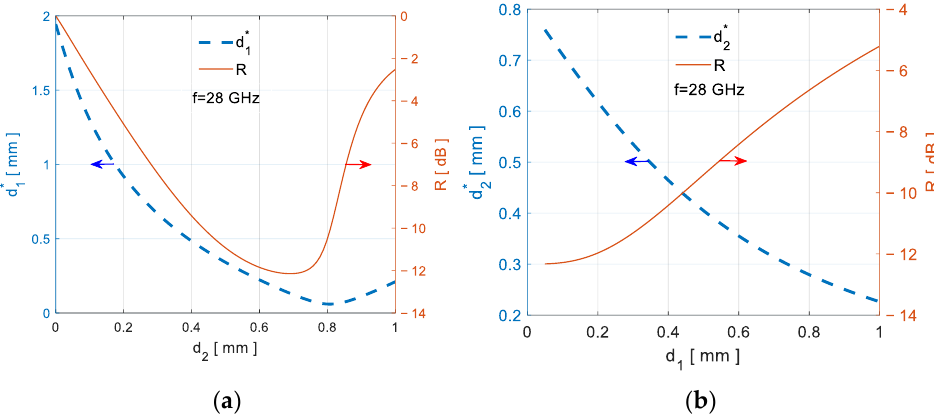
( d ) ( b ) at target frequency of 26 GHz. 1 *( d 2 ) ( a ) and d 2 * 1